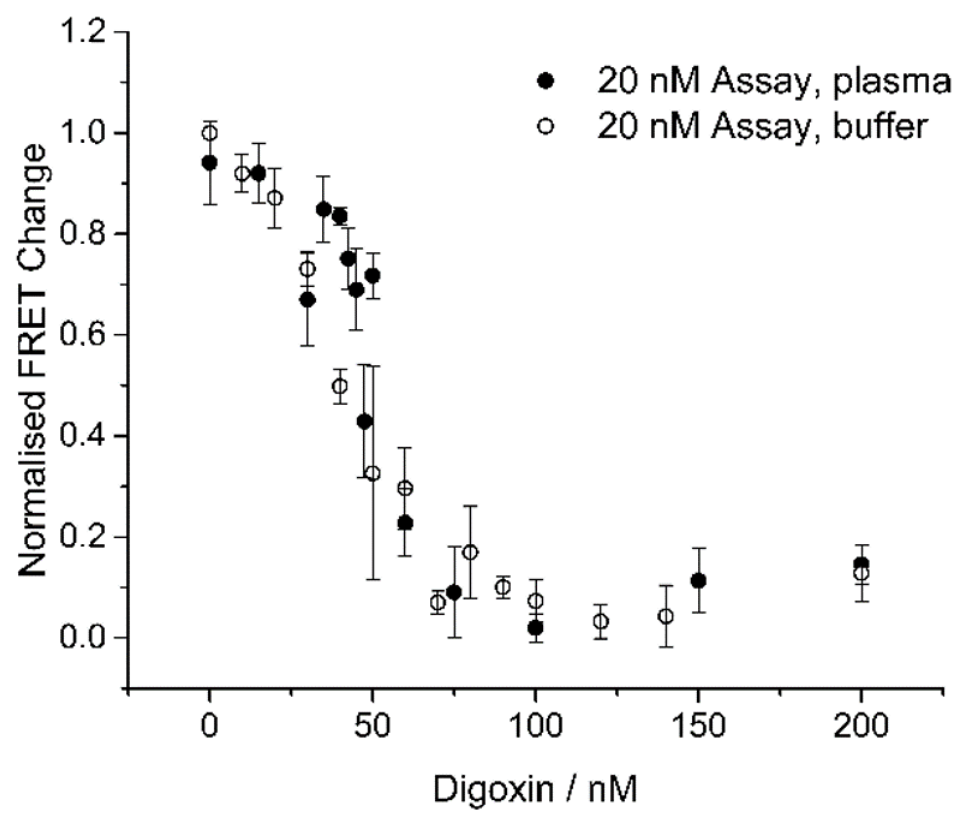
Figure 9. Comparison of 20 nM assay in buffer and in plasma. Normalized FRET change (A:B:S:aD = 1:1:1:1) relative to variable digoxin concentrations (0 to 200 nM) in buffer and in